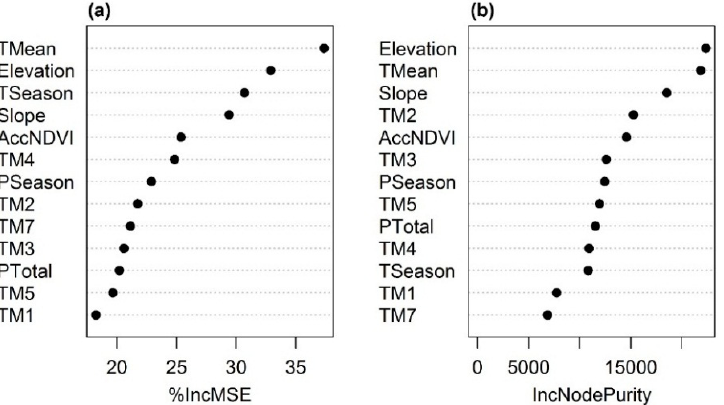
Figure 6. Variable importance for the tree height estimation Radom Forest model, denoted by ( a ) the percentage increase of mean-squared error (%IncMSE) and ( b ) the increase in node purity (IncNodePurity). PTotal, PSeason, TMean, TSeason, AccNDVI, and TM 1–5 and 7 represent